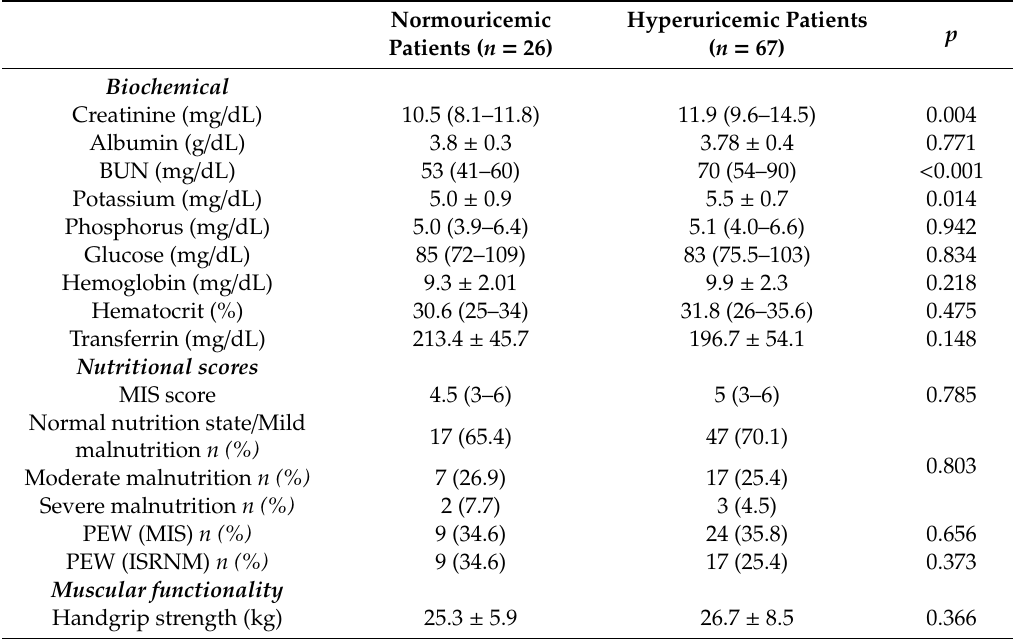
Table 3. Biochemical and nutritional parameters in normo and hyperuricemic patients on hemodialysis.